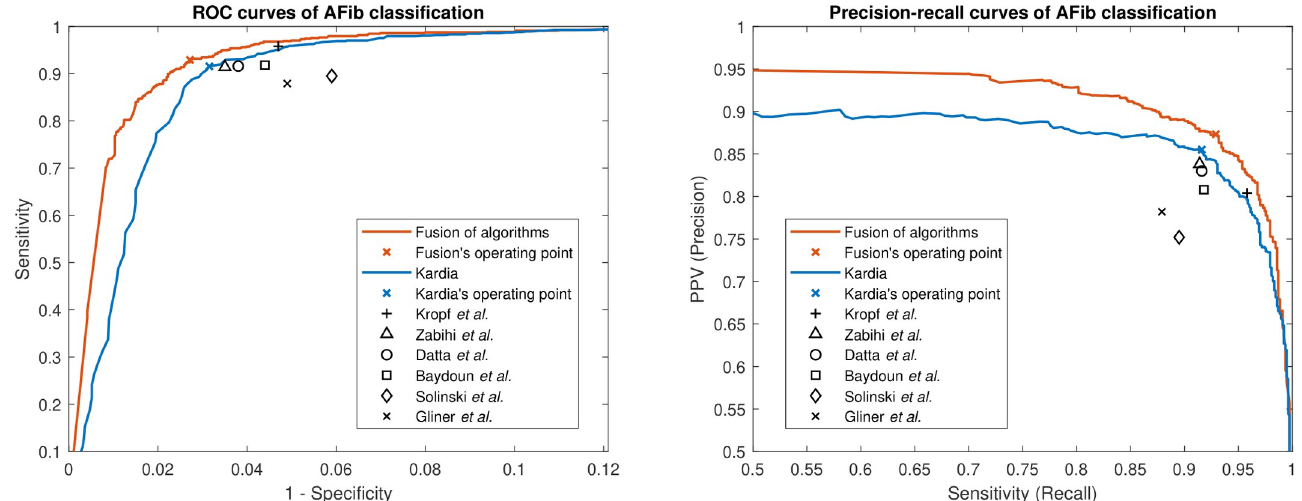
Fig 1. ROC and precision-recall curves. The left panel shows the ROC curves of our proposed algorithm (fusion of algorithms) and Karida. Since the other six algorithms do not generate class-specific continuous output (they generate only a class label), their operating points are indicated with one point defined by their sensitivity and specificity. The right panel shows the precision-recall curves of our proposed algorithm and Kardia along with the operating points of the other six algorithms.